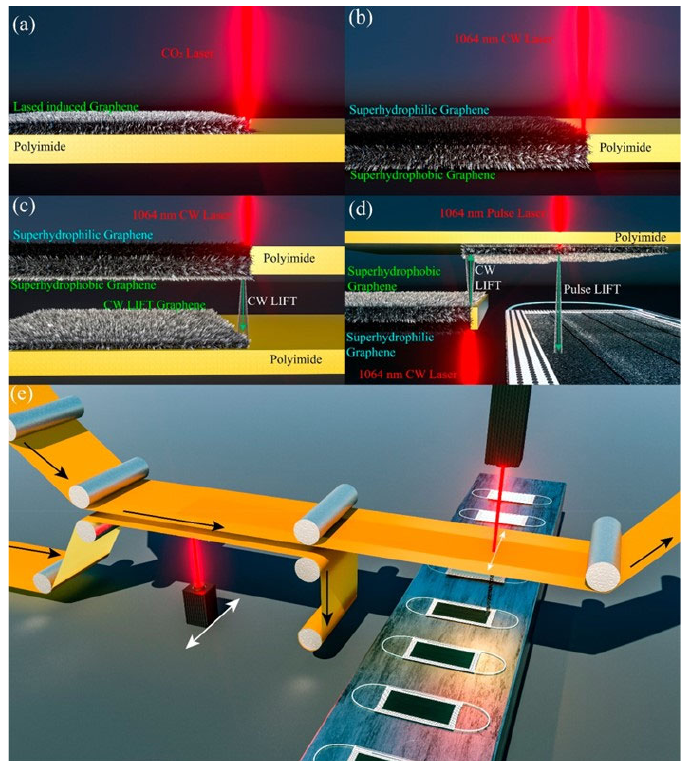
Figure 8. Comparison of different laser-induced graphene methods. ( a ) First-generation direct laser-induced graphene on a polyimide surface using a CO 2 laser. ( b ) Second-generation Janus superhydrophobic/superhydrophilic surface by 1064 nm laser scribing on polyimide. ( c ) Third-generation CW-LIFT of graphene from polyimide to acceptor polyimide. ( d ) Fourth-generation dual-mode LIFT, with CW-LIFT transfer of graphene onto a second polyimide and then pulse-LIFT transfer of graphene onto a temperature-sensitive mask. ( e ) Illustration of the compatibility of the dual-mode LIFT for roll-to-roll production of a graphene-coated mask. The roll movement direction is shown as the black arrow, and the laser movement direction is indicated by the white arrows. Reprinted with permission from ref. [123]. Copyright 2022 American Chemical Society.